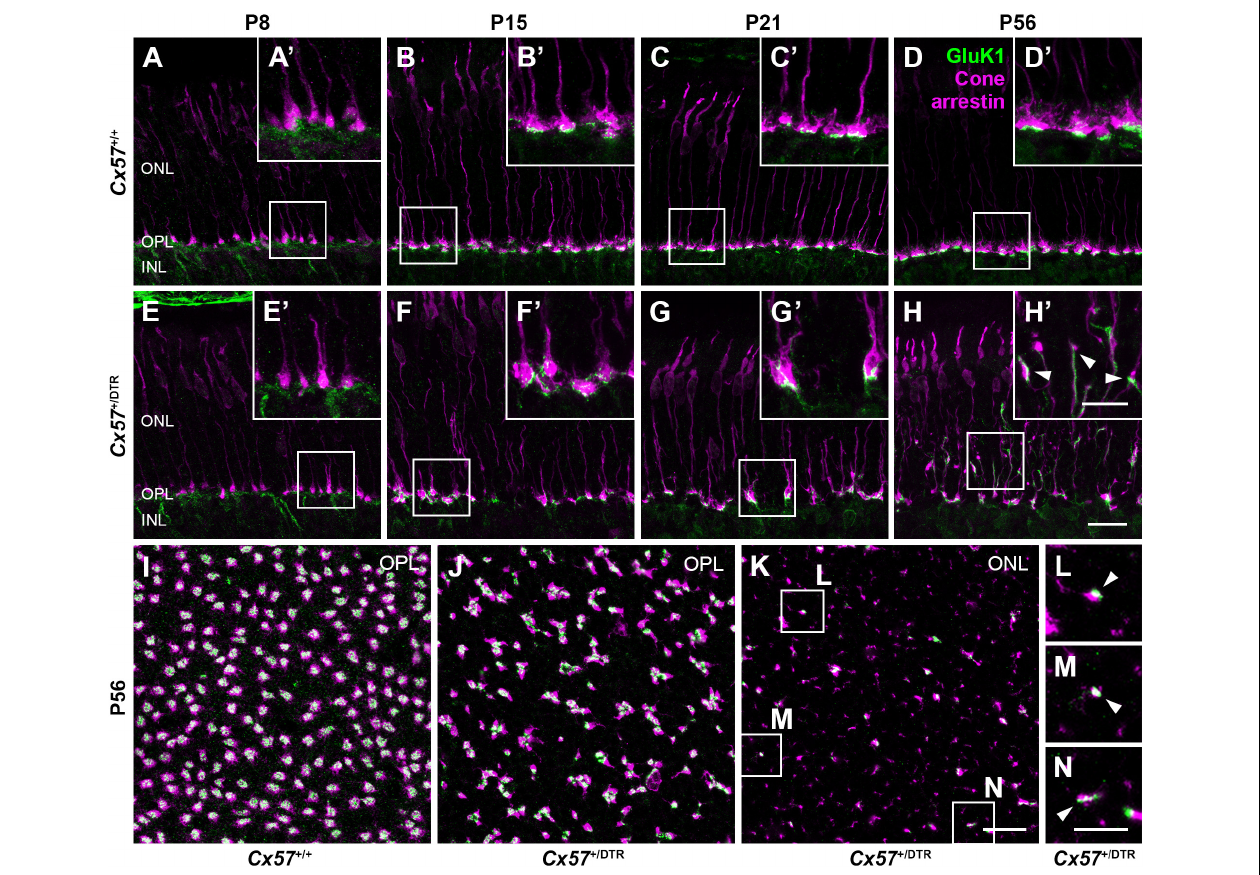
FIGURE 10 | Cones established new synapses with OFF bipolar cells. (A–H’) Double labeling of vertical sections from Cx57 + / + and Cx57 + / DTR retinae for the kainate receptor subunit GluK1 and the cone marker cone arrestin. In wild-type and horizontal cell-ablated mice, GluK1 immunoreactivity was found below the base of the cone terminals in the OPL from P8 to P56 (A–H) . In Cx57 + / DTR retinae, at P56, outgrowing GluK1-positive dendrites made contacts with the newly formed cone terminals in the ONL (arrowheads) (H’) . (I–N) Double staining of retinal whole mounts from Cx57 + / + (K) and Cx57 + / DTR mice (P56) (L–N) for GluK1 and cone arrestin. At the level of the OPL, cone terminals were associated with GluK1 staining in both genotypes (I,J) . Ectopic cone terminals in the ONL of horizontal cell-ablated mice were directly connected to GluK1-positive dendrites (arrowheads) (K–N) . Scale bars, 20 µ m (H,K) , 10 µ m (H’,N)